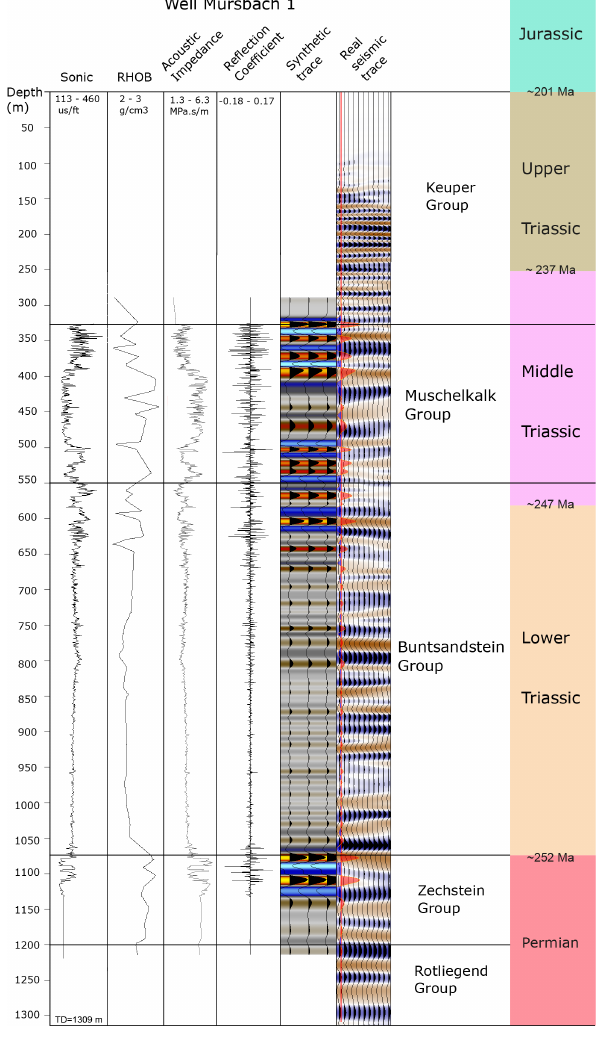
Figure 2. Velocity and density logs from the Mürsbach 1 well utilized for synthetic seismogram generation. Seismic traces from FRANKEN-1802 are compared with synthetically generated seis- mograms. Velocity data are used to construct time–depth relation- ships and well seismic ties. Depth to the formation tops are time- converted and used as a starting point for seismic